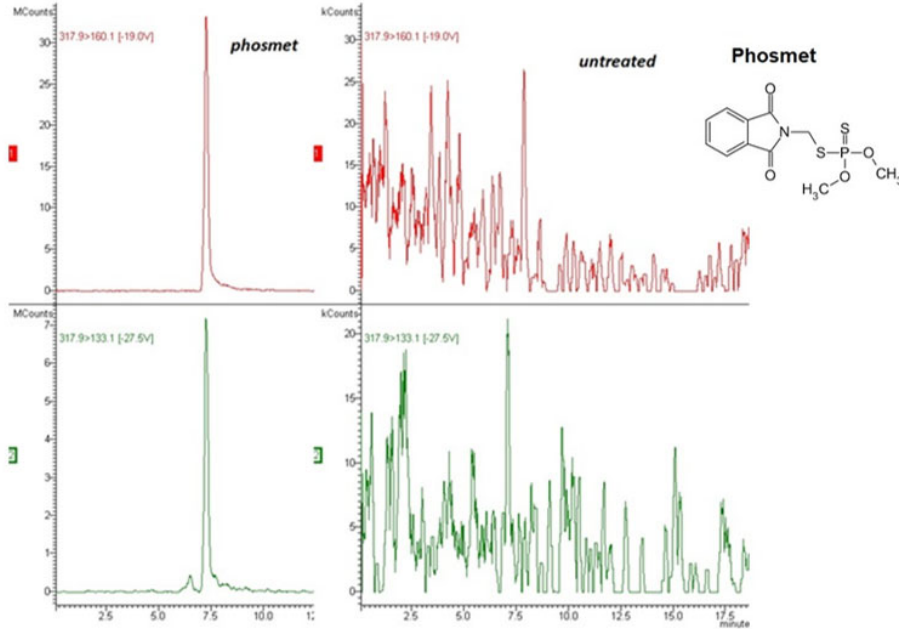
Figure 2. Determination of phosmet residues in the surface of olive leaves using LC ‐ MS/MS system. GC–(EI) ‐ MS/MS: A gas chromatography system interfaced with a triple quadrupole mass spectrometer (Varian 1200 L, Lake Forest, CA, USA) was involved for residue iden ‐